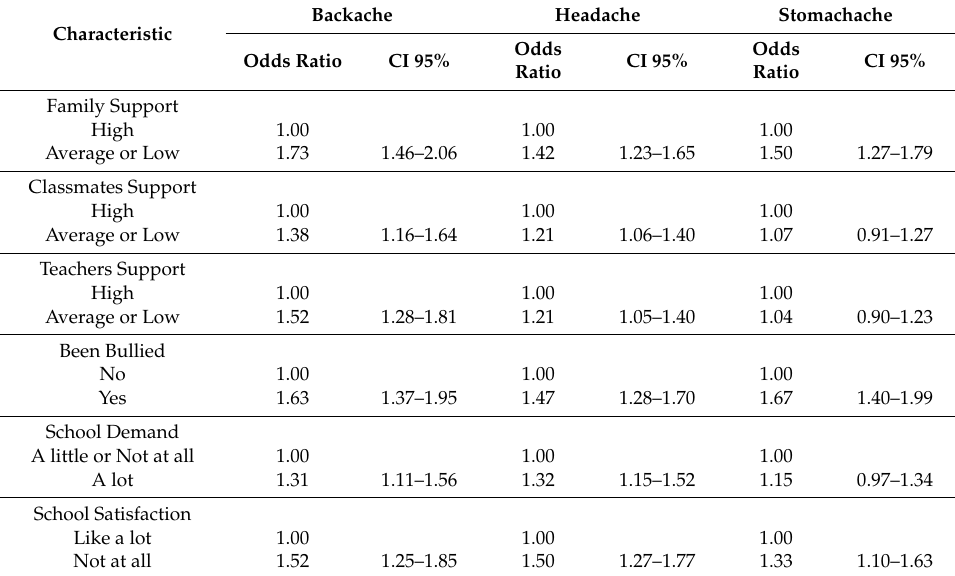
Table 5. School factors and somatic complaints: univariate logistic regression.